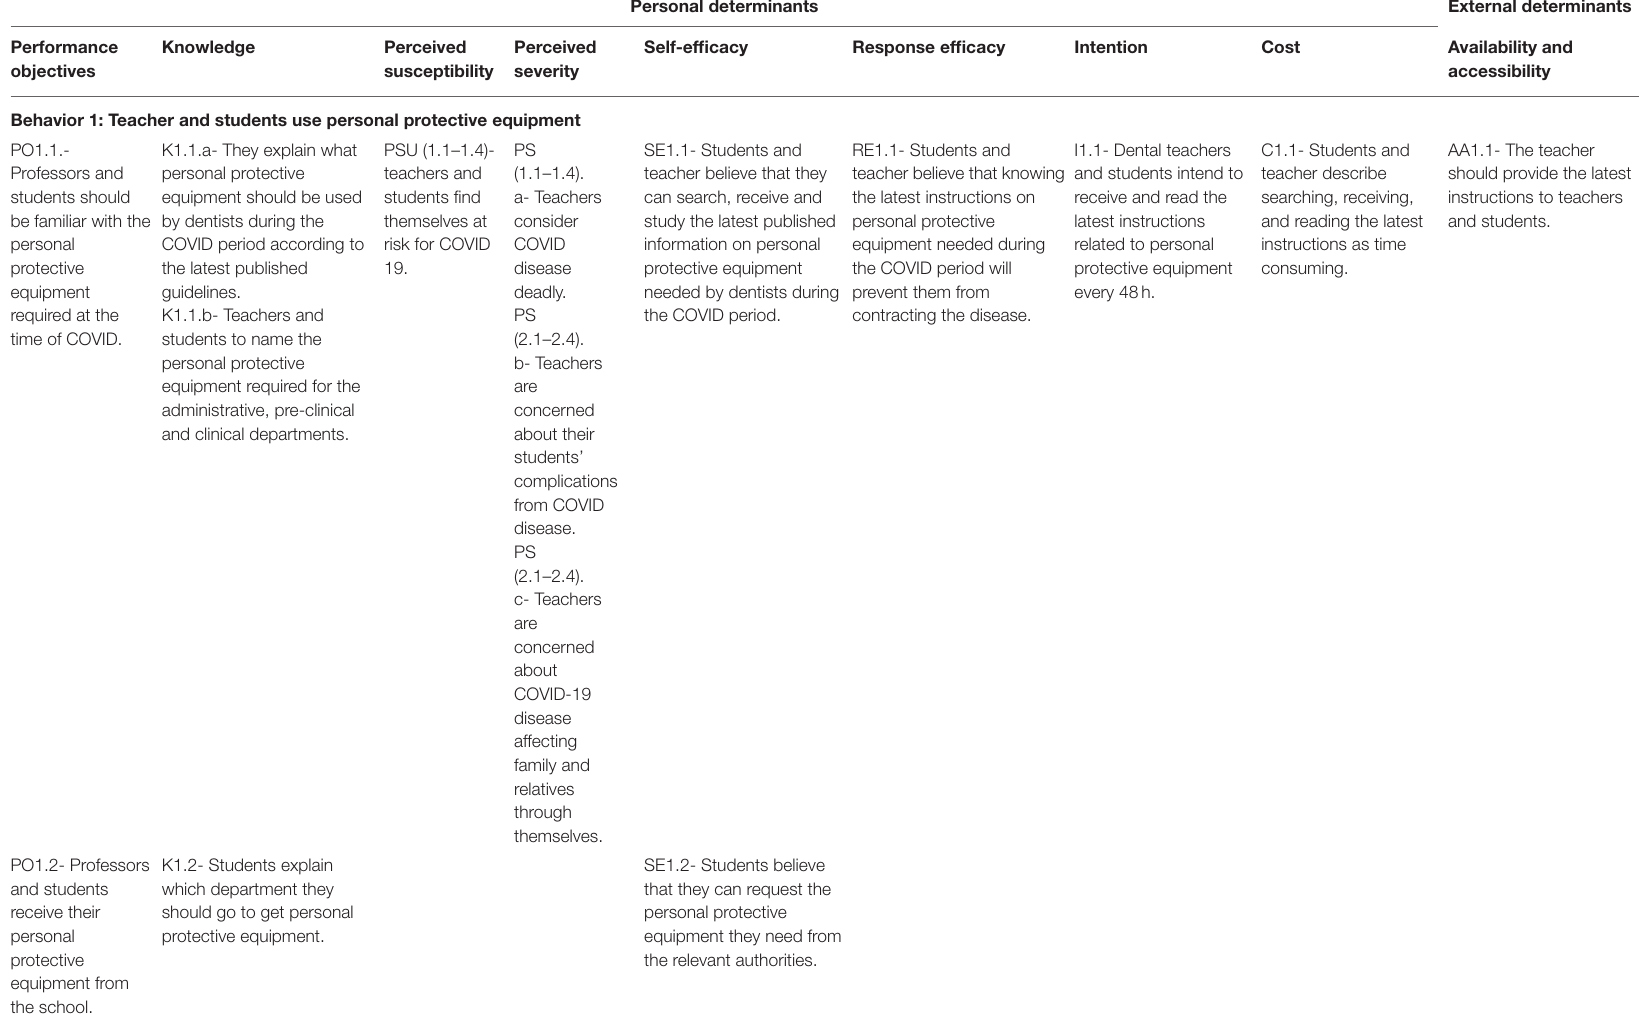
TABLE 2 | The matrix of change objectives for teacher and